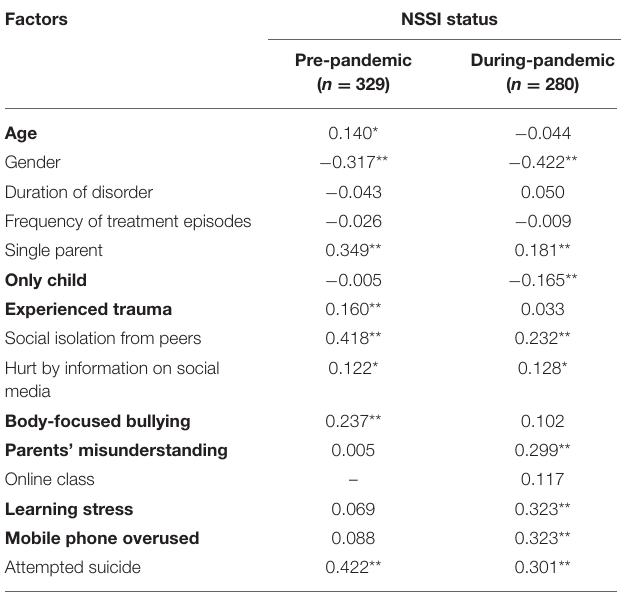
TABLE 3 | The correlation between NSSI and psychosocial factors in different